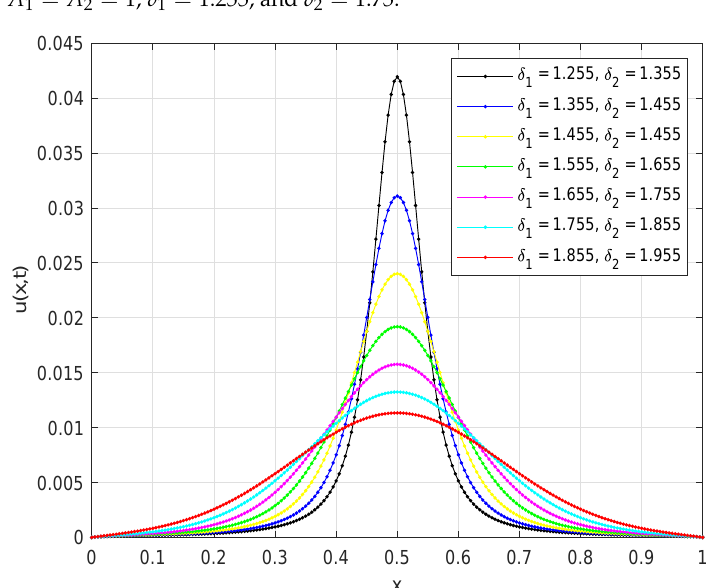
Figure 2. Example 1: Numerical solutions using for different values of δ 1 and δ 2 using h = k = 1/200, l = 2, K = 1, and A 1 = A 2 =